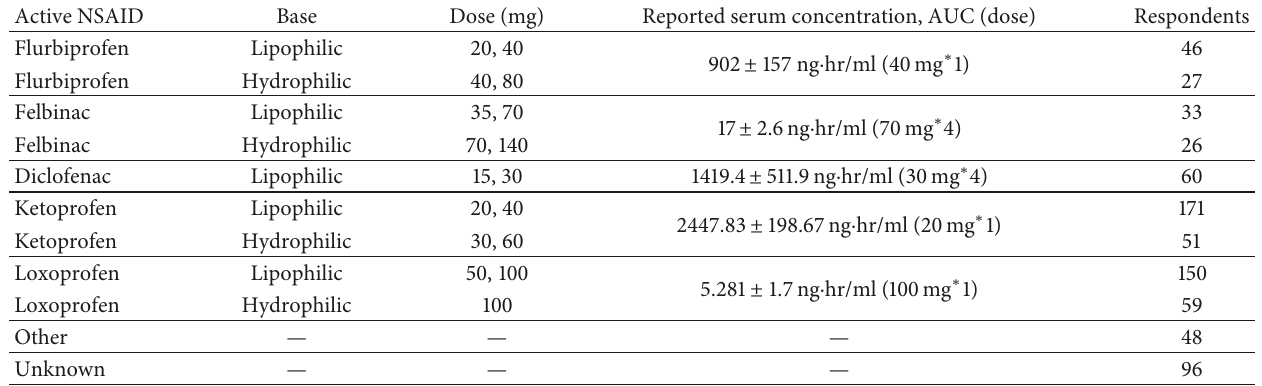
Table 1: NSAID types and available doses.